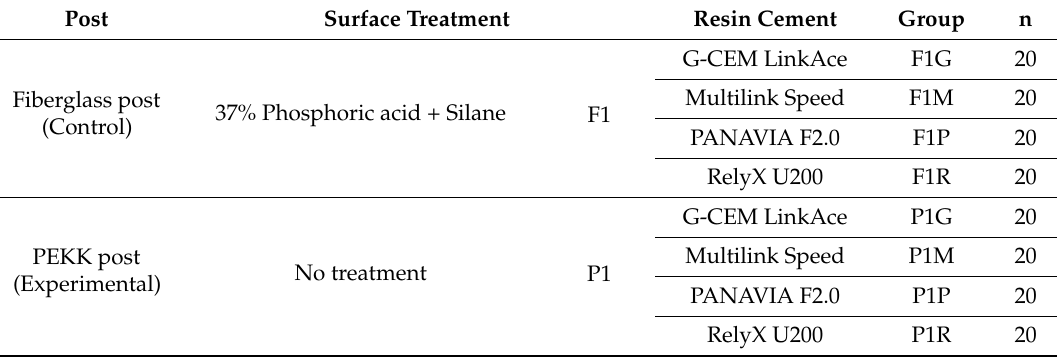
Table 2. The control and experimental groups. The fiberglass posts, which are the control groups, were named F1M to F1R according to the resin cements applied after the surface treatment according to the manufacturer’s recommendation. The PolyEtherKetoneKetones (PEKK) posts, which are the experimental groups, were named P1M to P4R, abbreviated according to the surface treatments and the resin cements applied on the PEKK posts. For each group, 20 specimens were used for this test.